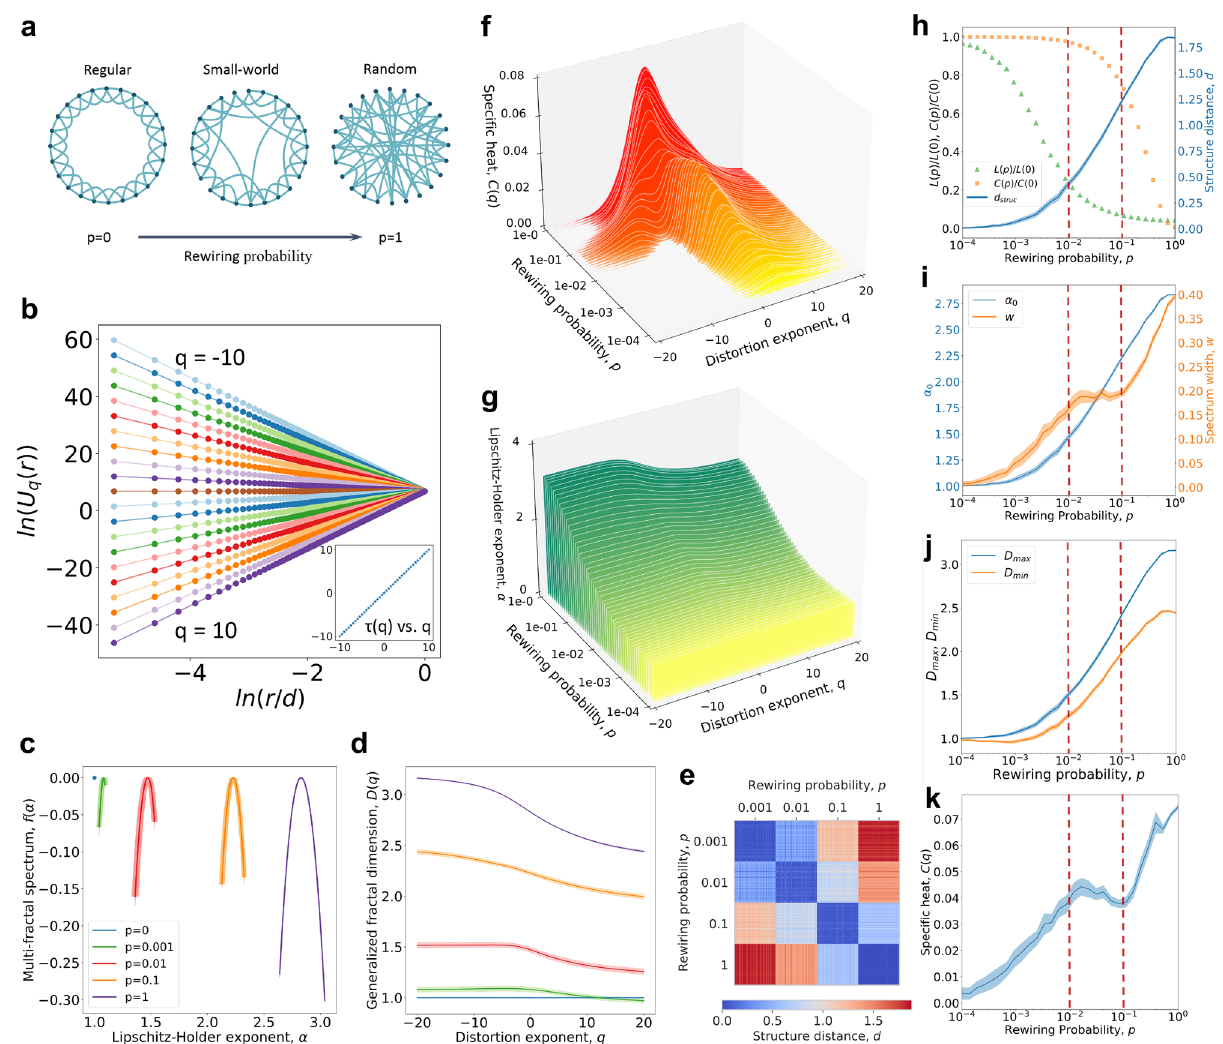
Figure 2. The evolution of the Watts–Strogatz network. ( a ) The mechanism of the Watts–Strogatz network, which starts from a regular network. As the rewiring probability increases, the randomness increases, the network gradually becomes random. ( b ) The logarithmic relationship between the partition function and the scale, and the linear relationship between the mass exponent τ( q ) and q for the initial regular network with the rewiring probability p = 0 . ( c–e ) The multifractal spectrum ( c ) and the generalized fractal dimension ( d ) of 1000-node Watts–Strogatz networks with p = 0, 0.001, 0.01, 0.1, 1 (for each p , the analysis is repeated 100 times). ( e ) The structure distance between the 400 networks with p = 0.001, 0.01, 0.1, 1 (we generate 100 networks randomly for each p ). ( f,g ) The variations in the distribution of the specific heat ( f ) and the Lipschitz– Holder exponent ( g ) when p increases from 0 to 1 (we take 50 sets of p at equal intervals, repeat 100 times for each p and use the mean value). ( h–k ) As p increases from 0 to 1, the evolution of the structural distance from the initial regular network ( h ); the degree of the complexity α 0 and the heterogeneity w ( i ); the measure of fractal dimension D max , D min ( j ); and the measure of specific heat C ( q ) ( k ). The solid lines in figures represent the mean value while the shades being the 99% confidence exponent α , the derivative of α , and the distortion exponent q are analogous to the free energy, the energy, the specific heat, and the temperature in thermodynamic systems 26–28 , respectively. The phase of a thermodynamic system has uniform physical properties. The phase transition means that certain properties change discontinu- ously under a critical external condition. Consequently, we can investigate the phase transitions of a network by studying whether the network “energy” α undergoes a sharp jump near a critical “temperature” q c . In the α distribution under q , the “energy” α has a large fluctuation near q c , which can be reflected by the peak of the specific heat C ( q c ) . For q values below q c , the “free energy” τ is dominated by the largest energy term α max , which indicates a network structure with high singularity index. After the large energy fluctuation near q c , the domi- nant part becomes the small energy term α min . Therefore, the specific heat can be also considered as a measure of the difference between high and low singularity in the network structures.